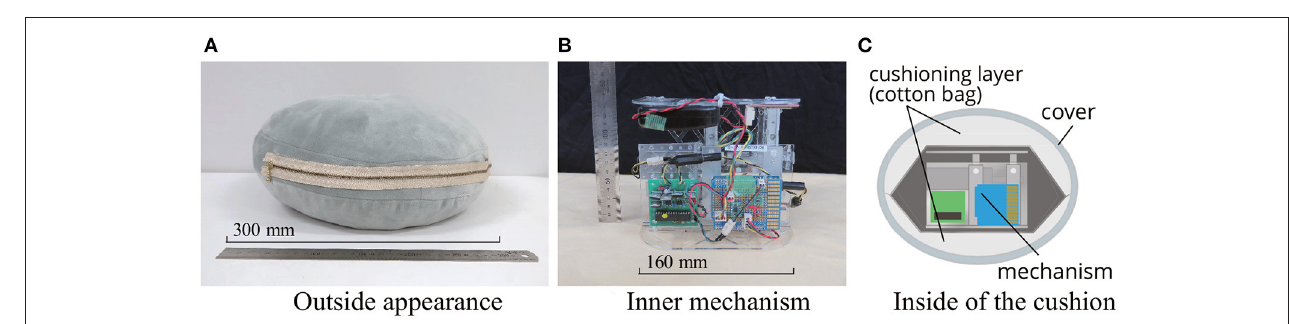
FIGURE 3 | Appearance of the cushion-type device. The mechanism (B) is housed in the cushion (A) . The inside of the cushion had a two-layer structure, and the mechanism was placed in a cavity surrounded by cushioning layer made of cotton (C) . Due to the cushioning layer, the user did not feel the stiffness of the mechanism and the driving noise of the motor was